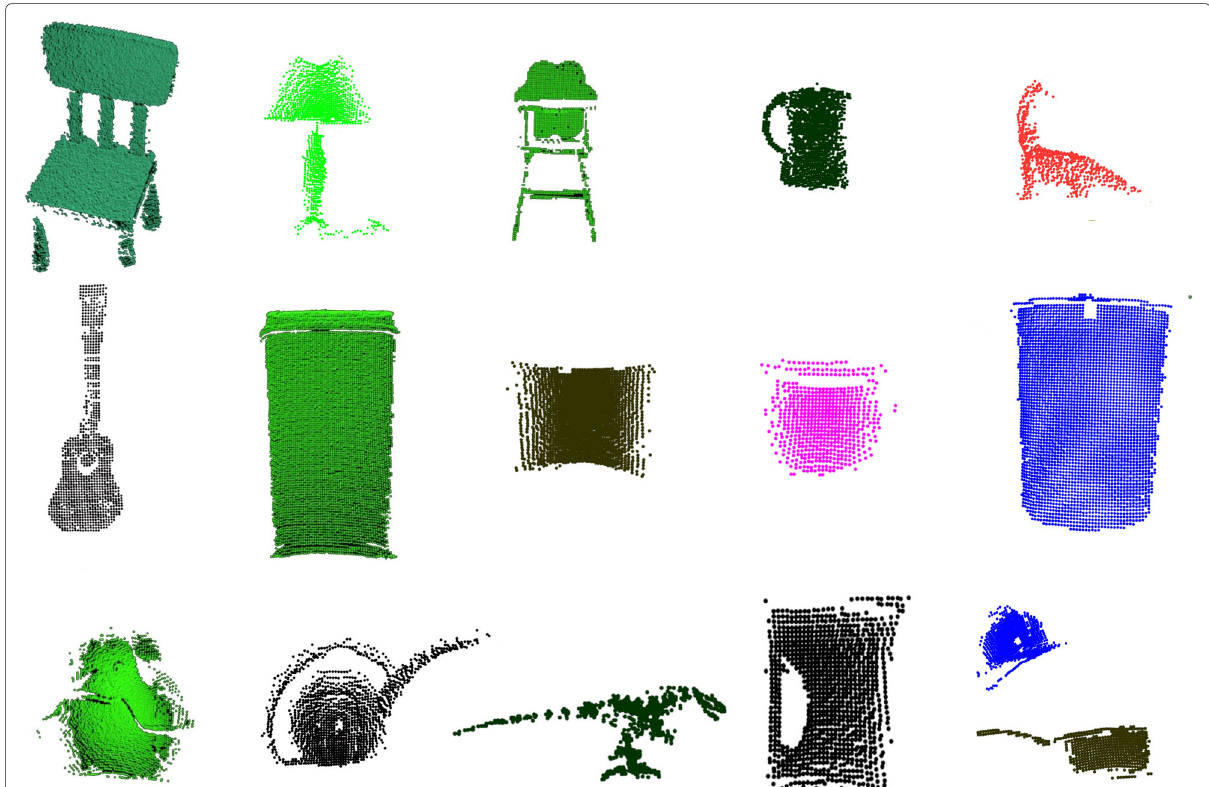
Fig. 17 SR4K-D dataset made from SwissRangers Time-of-Flight camera with different household